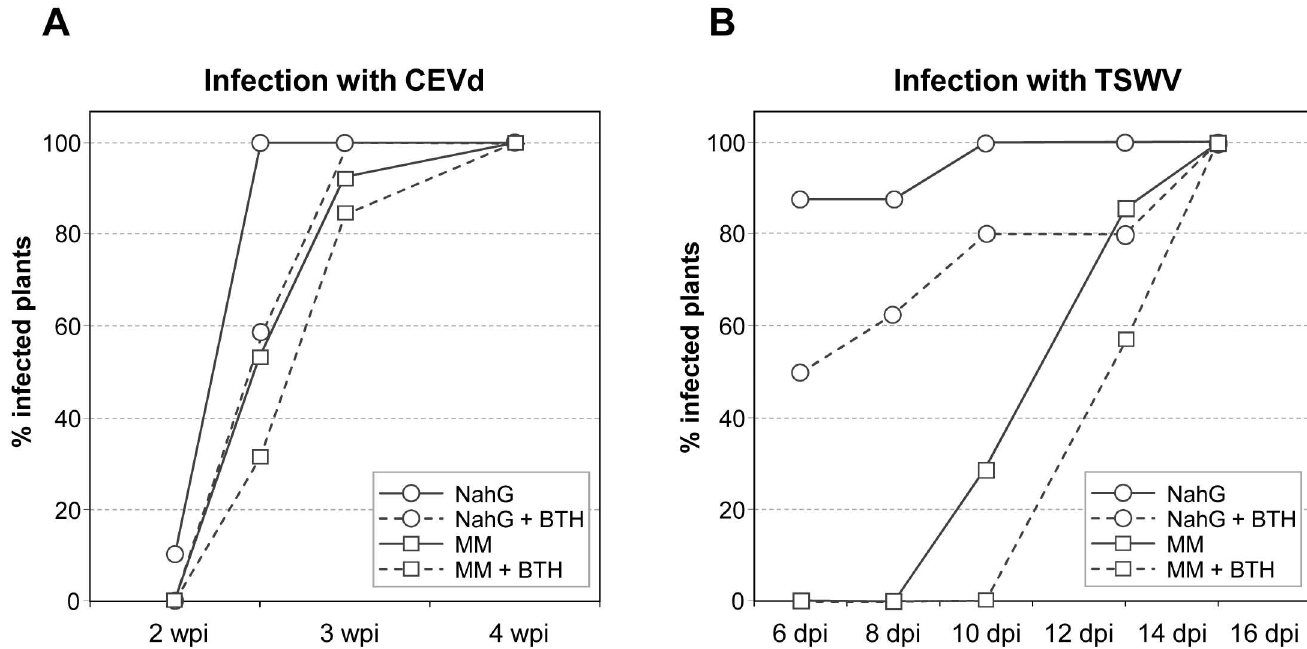
Fig 5. Diseasedevelopment in Money Maker and NahG plants infected with A) CEVd or B) TSWV. Plants were treated either with water (continuous line) or BTH (discontinuous line). Evolution of the numberof tomato plants showingsymptoms at the indicateddays post-inoculation (dpi). Data correspond to one representative